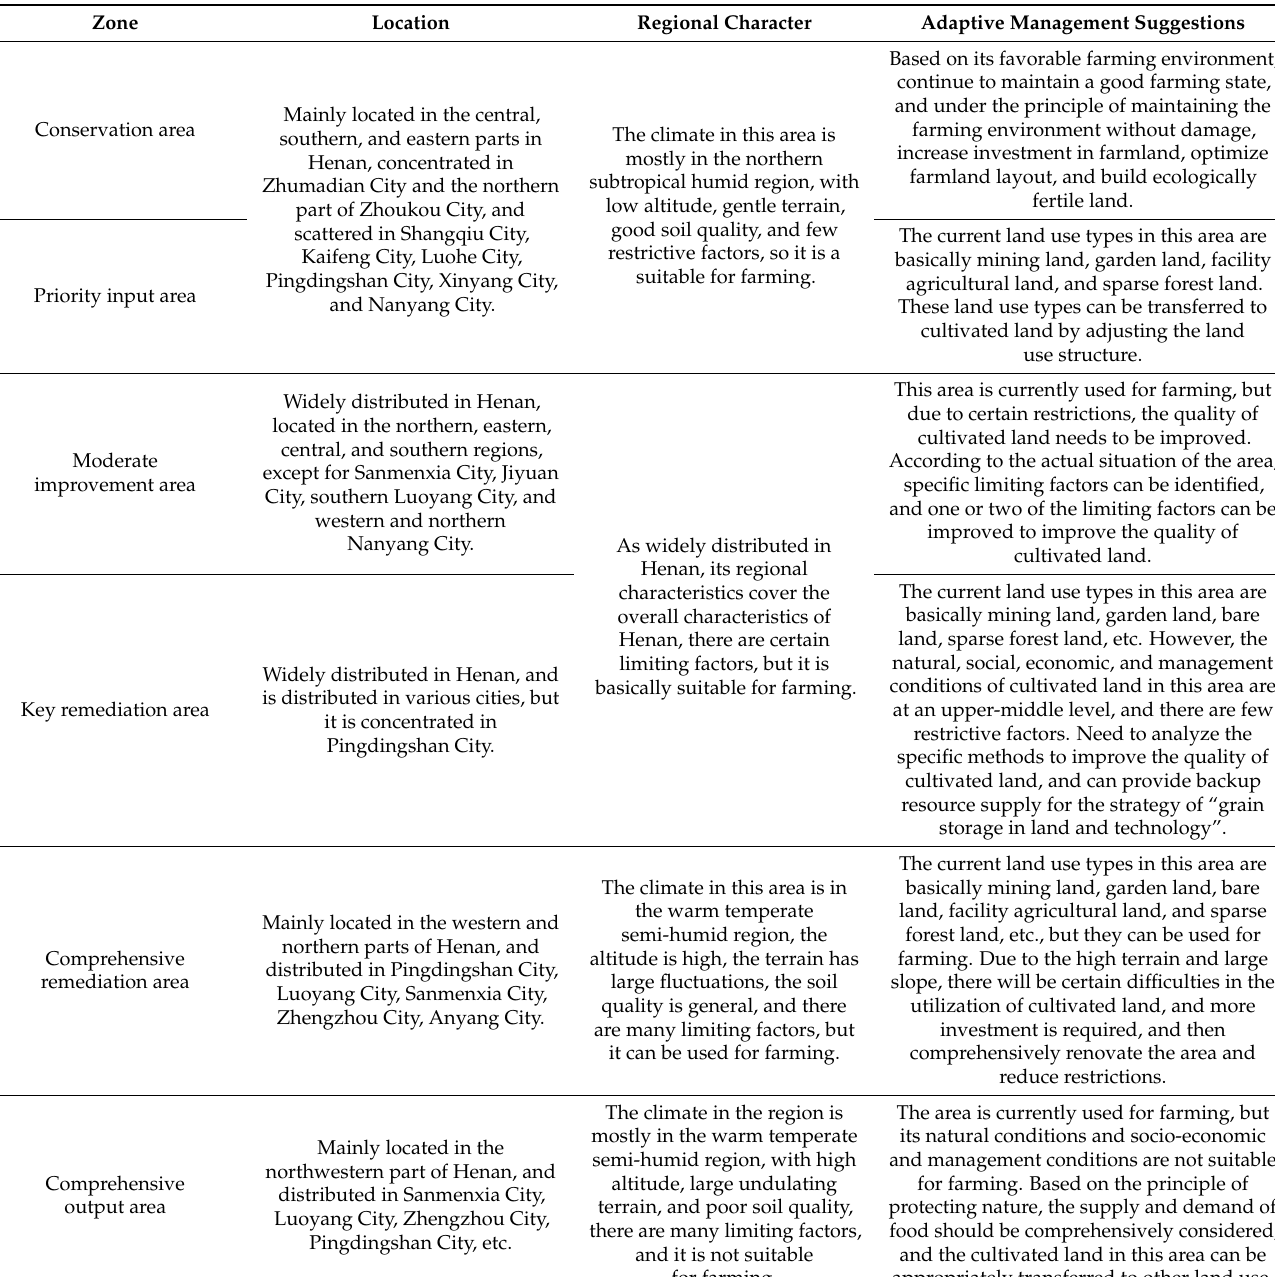
Table 4. Adaptive management suggestions in different management